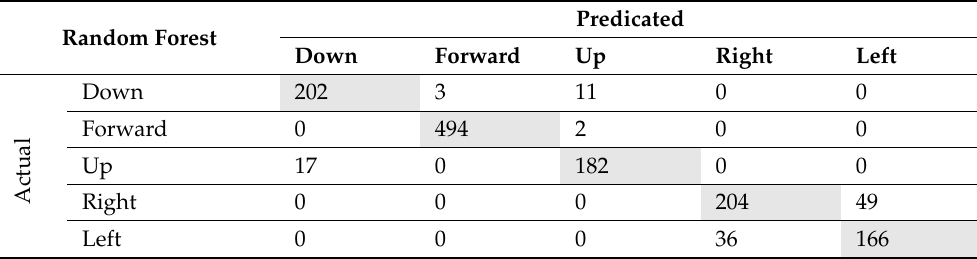
Table 4. Five-class confusion matrix for the long sensor. Rows represent actual class and columns represent predicted class.